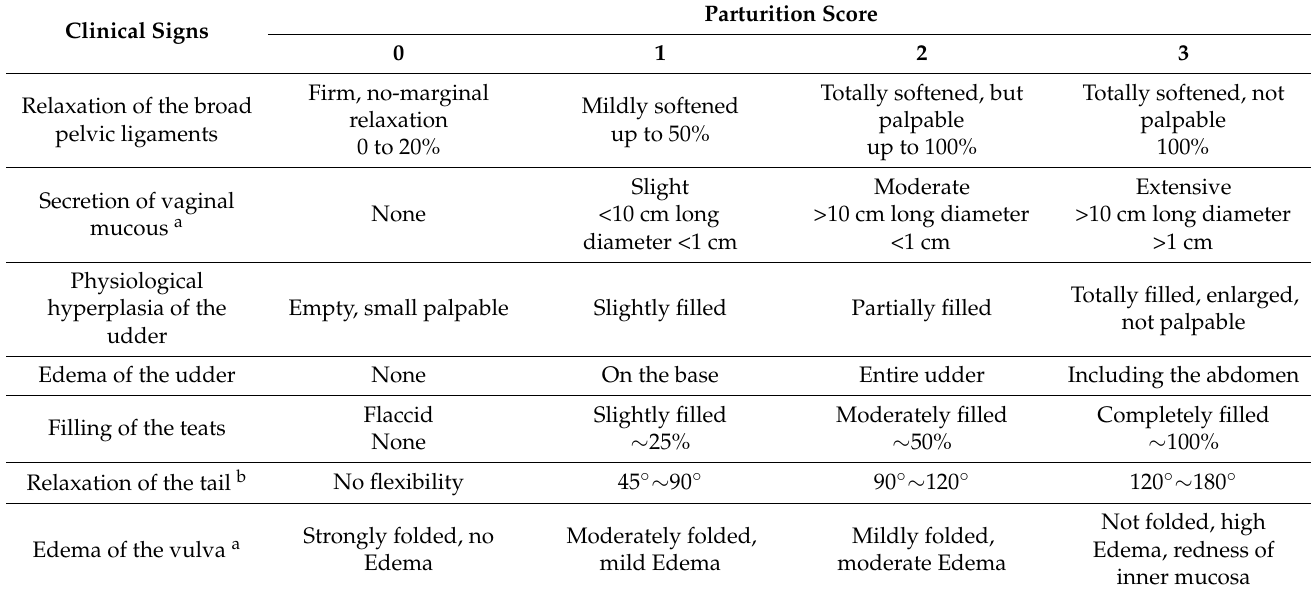
Table 1. Use of different clinical signs during the preparatory stage of cattle for a parturition scoring system